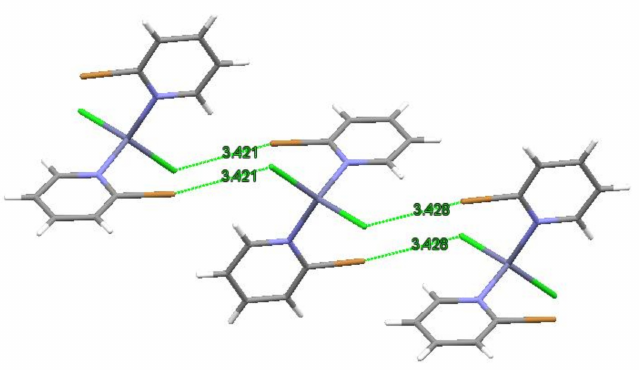
Figure 7. Halogen bonding Br ··· Cl in heteroleptic molecular complex [(2-BrPy) 2 ZnCl 2